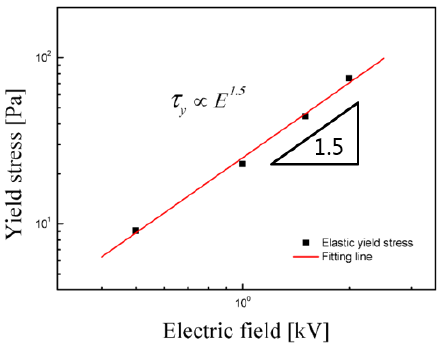
Figure 5. τ y versus electric field strength of the ER fluid containing 10 vol % PMMA-PNMA